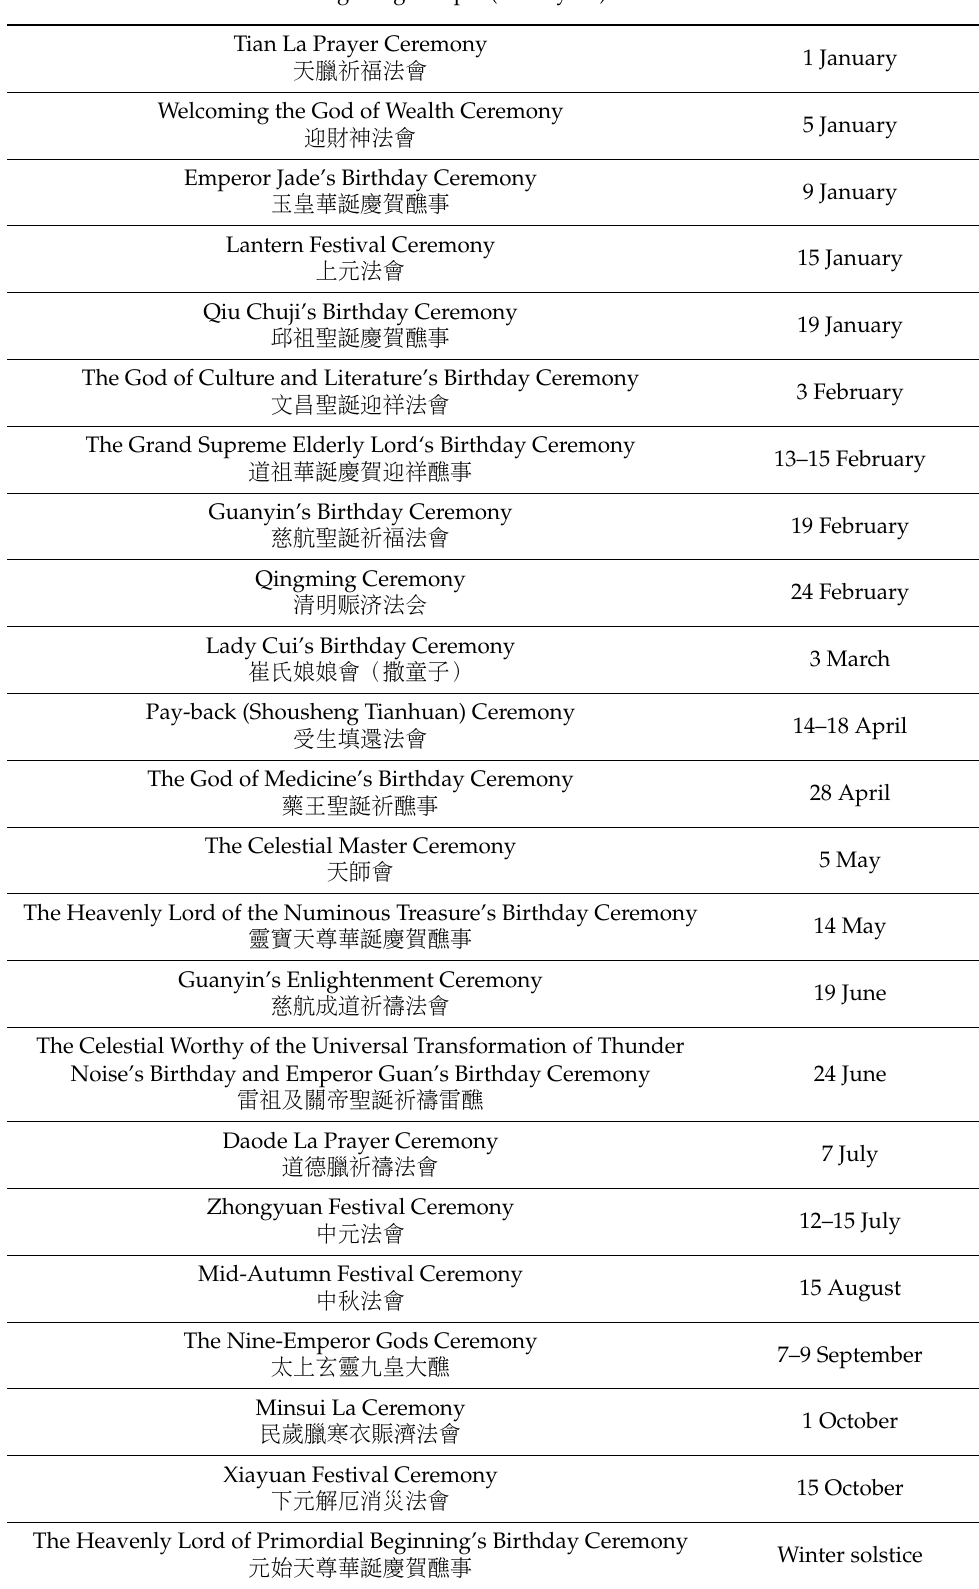
Table 3. The calendar of the Niangniang Temple (lunar